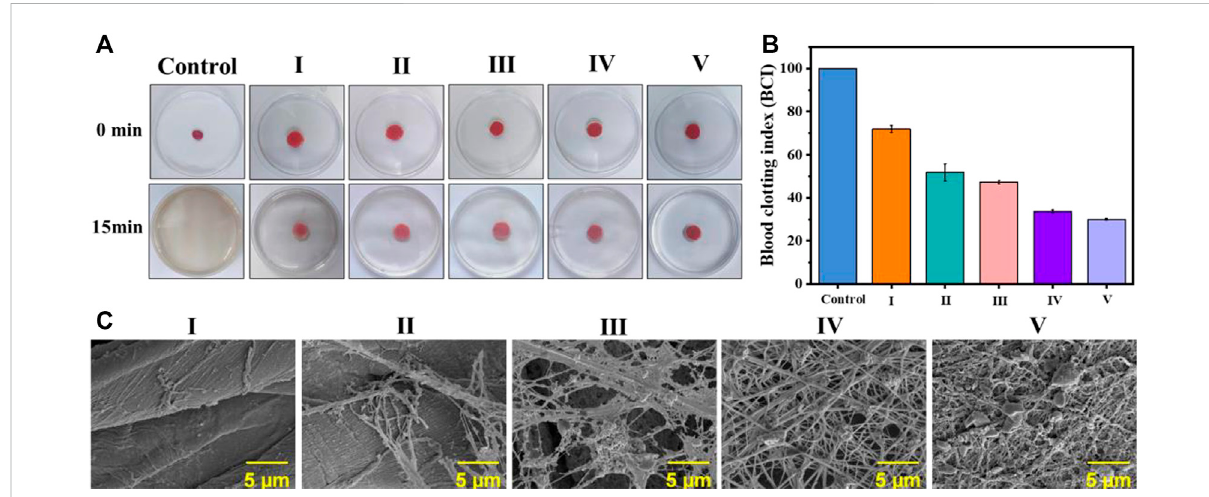
FIGURE 5 Invitro bloodcoagulationandhemolysisassessmentonthecoatedcottonfabric: (A) thephotographsoftheblood-clottingprocess; (B) theBCI valueof whole blood clotting evaluation of thecoated cottonfabric, nonwoven and control; and (C) platelet pseudopods and fi brin network formed on different samples. I) cotton, II) cotton-SD, III) cotton-SD-PHMG 1 , IV) cotton-SD-PHMG 5 , V) cotton-SD-PHMG 10